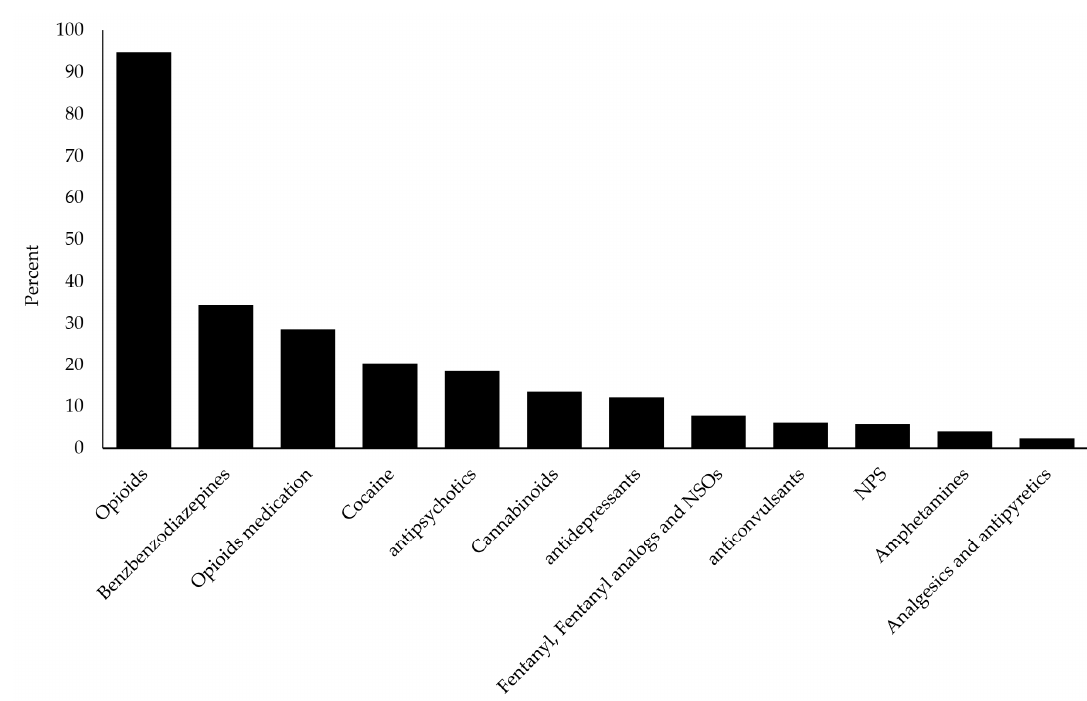
Figure 1. Percentage plot of classic drugs and new psychoactive substances found in 296 urine samples from former heroin users at methadone maintenance clinics and drug addiction services .